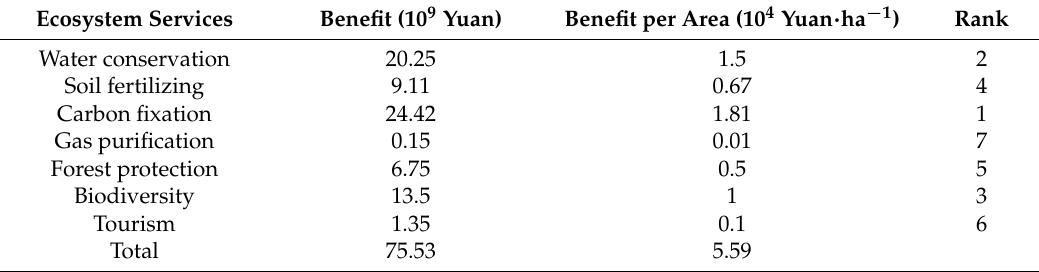
Table 3. Ecological income in Yanqing District in